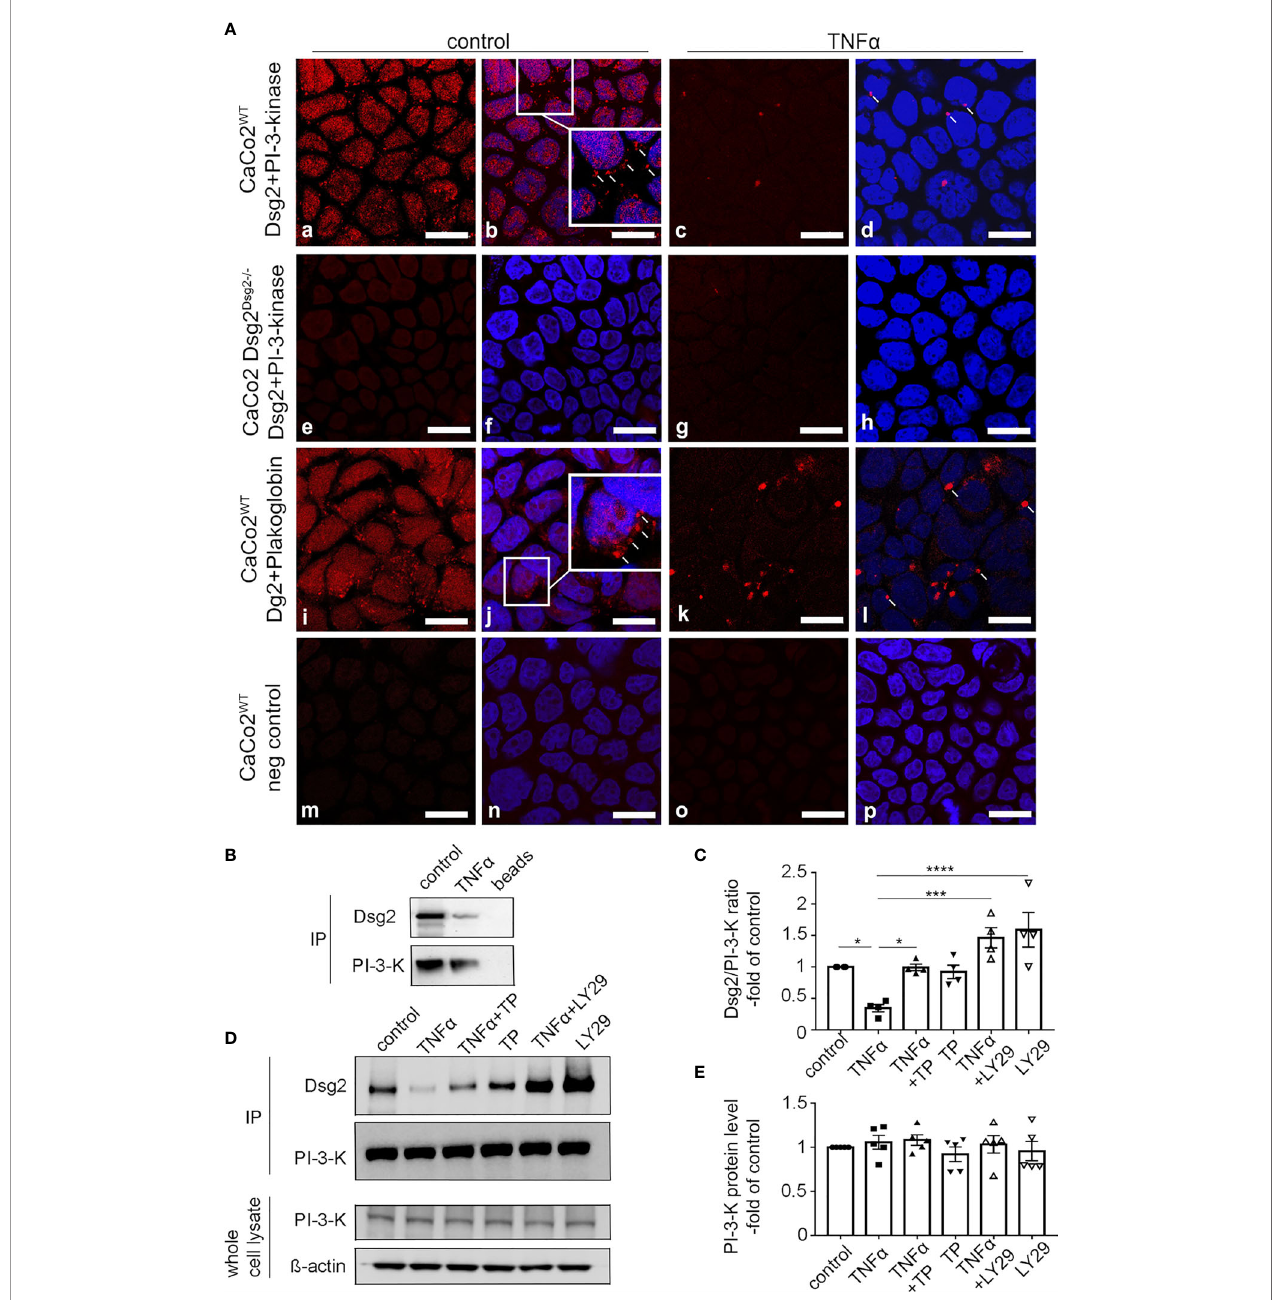
FIGURE 8 | Dsg2 and PI-3-K show direct interaction. (A) Images following Proximity ligation assays (PLA) are shown. Images were stained with DAPI to visualize cell nuclei (b, f, j, n, d, h, l). In Caco WT (a-d) red fl uorescent spots within cells are shown after incubation of cells with antibodies directed against Dsg2 and PI-3-kinase under basal conditions (a, b). Insert in (b) highlights spots at the cell periphery. Incubation of monolayers with TNF a reduced the number of spots (c, d). PLAs using Caco Dsg2-/- (e-h) under the same conditions and Caco WT without primary antibodies (m-p) served as negative controls. Caco WT were stained with Dsg2 and Plakoglobin as positive control (i-l); images shown are representative for n=5 experiments. Scale bar is10µm. (B) , (C) Co-Immunoprecipitations (IP) are shown that were performed with 2.5µg PI- 3-kinase antibody in Caco2 WT cells under control conditions, incubated for 24h with TNF a (100 ng/ml), TP (20 µM), LY294002 (20 µM, PI-3-kinase inhibitor) or in combination. Beads without primary antibody served as negative controls. Western Blot of PI-3-kinase from whole cell lysates of Caco2 Dsg2 WT is also shown. ß-actin served as loading control. (D) Quanti fi cations of all IPs from (C) are presented. Quanti fi cations were carried out by calculating Dsg2/PI-3-kinase ratio from the ODs; n= 4 experiments, Ordinary 1-way ANOVA Asteriks mark signi fi cant differences *p < 0.01, ***p < 0.0001, ****p < 0.00001; comparisons are indicated by the lines above the columns. (E) Quanti fi cation of PI-3-kinase protein level showed no signi fi cant difference, n=5, Ordinary 1-way